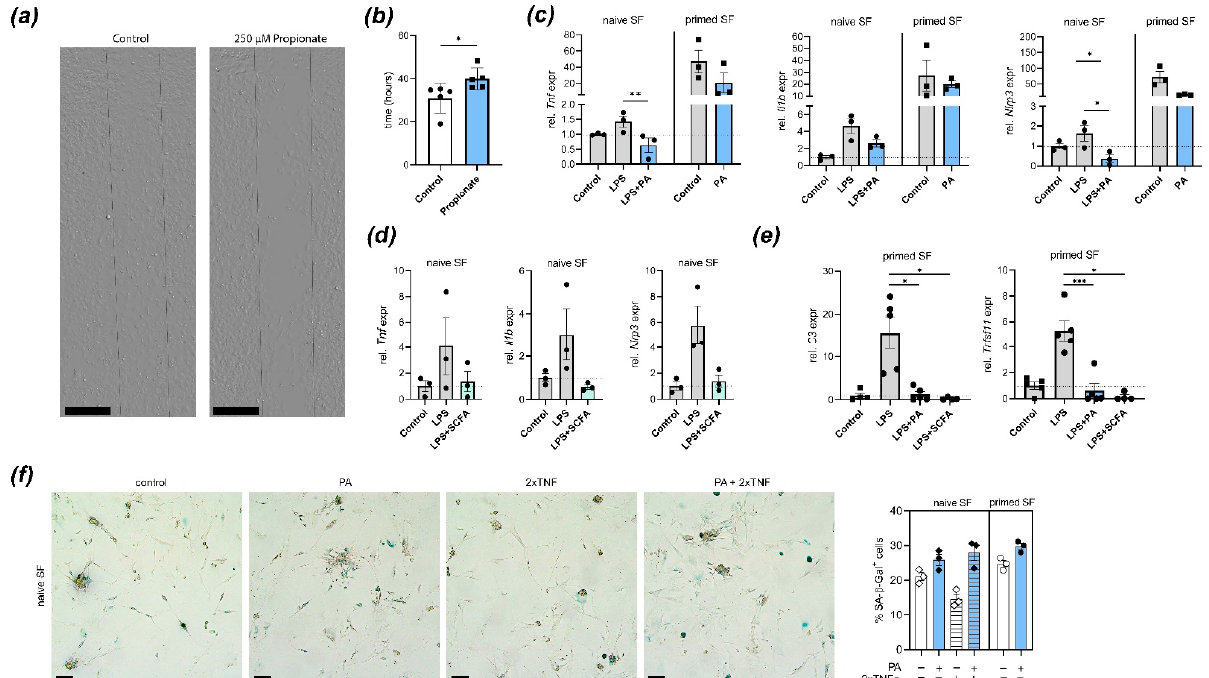
Figure 2. Treatment with propionic acid (PA) or SCFA blocks arthritogenic fibroblast function: ( a , b ) Fibroblast migration is reduced by treatment with PA. Representative images ( a ) of a wound healing/migration assay with murine SFs isolated from C57BL/6 mice. Dashed lines show cell-free space at experiment start. Scale bars, 400 µm ( b ) Quantification of wound healing/migration (time until confluency) in PA-treated and control murine SFs (n = 5). * p < 0.05, Student´s t -test. ( c ) Quantitative real-time PCR analysis in cultured naïve and primed mouse SFs stimulated with LPS with or without PA. Shown are expression of Tnf , Il1b and Nlrp3 . * p < 0.05, ** p < 0.01, ANOVA with Sidak´s multiple comparisons test. ( d ) qPCR analysis in cultured naïve SFs stimulated with LPS with/without physiological mixture of short-chain fatty acids (SCFAs; acetate, propionate, butyrate). Plotted are individual values and means of Tnf , Il1b and Nlrp3 expression. ( e ) qPCR analysis of LPS-stimulated and control SFs treated with PA or SCFA mixture. Shown is expression of C3 and Tnfsf11 (RANKL). * p < 0.05, *** p < 0.001, ANOVA with Sidak ´ s multiple comparisons test. ( f ) Representative images and quantification of propionate or vehicle-treated murine synovial fibroblast stained for senescence-associated β -galactosidase (blue). Scale bars, 200 µ m. All subfigures show individual values, means and S.E.M. Each symbol represents pooled cells from 2